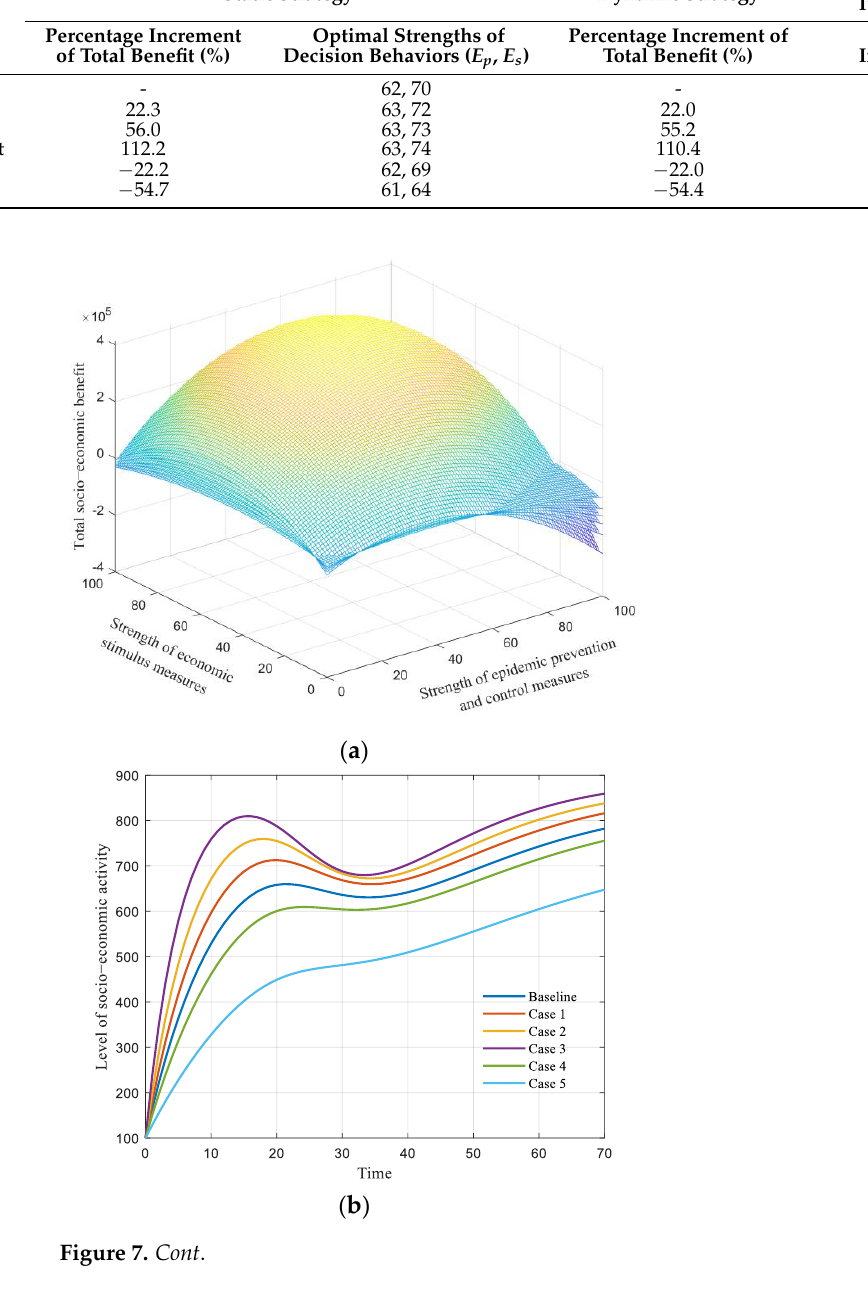
( c ) Figure 7. Results of static strategy in five cases with different model parameters. ( a ) Total so- cio-economic benefit with varying control variables in five cases. ( b ) Level of socio-economic ac- tivity along with time in five cases. ( c ) Total socio-economic benefit along with time in five cases.